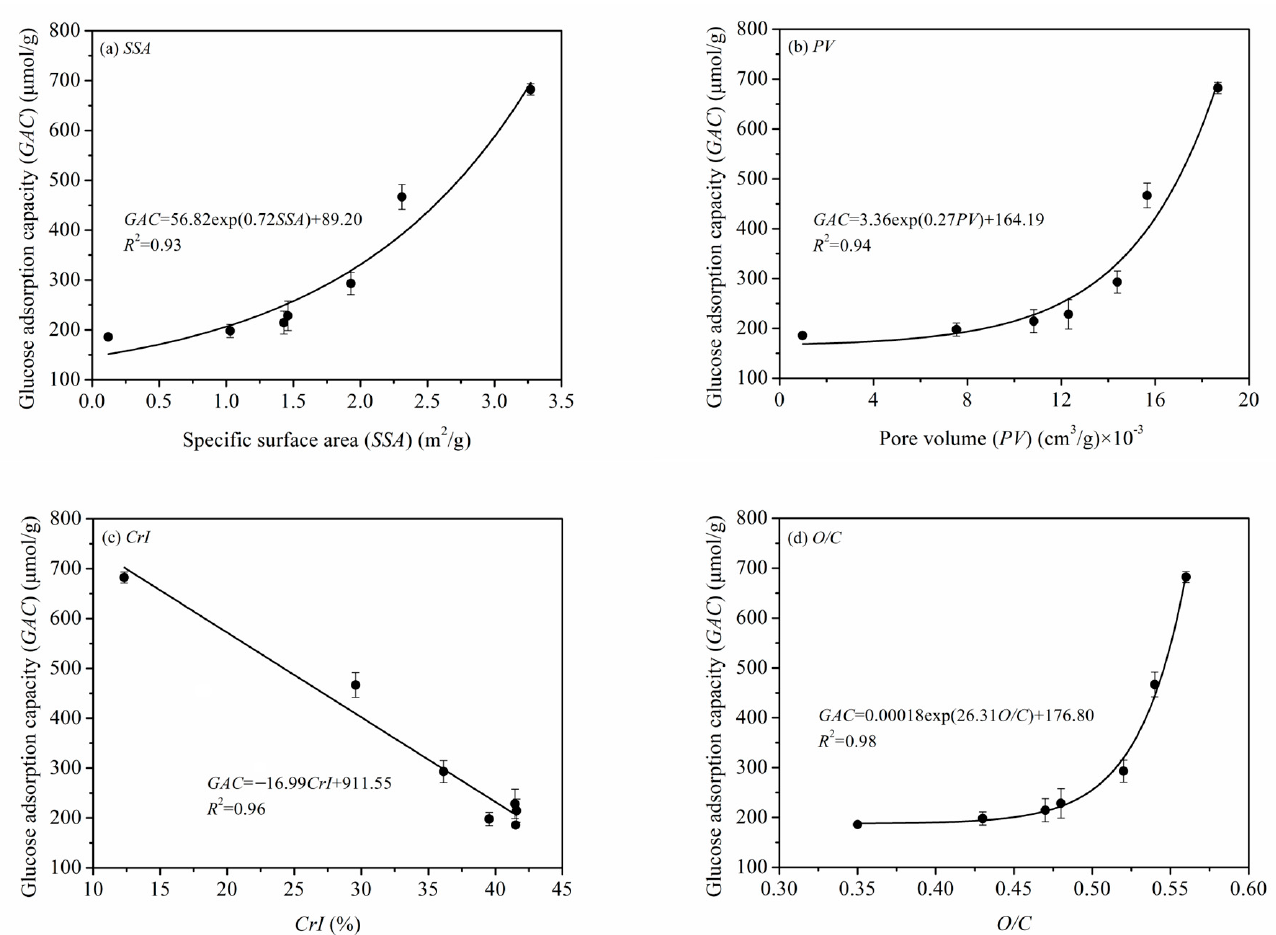
Figure 13. Quantitative relationships of SSA ( a ), PV ( b ), CrI ( c ), O/C ( d ) and GAC of PIDF.